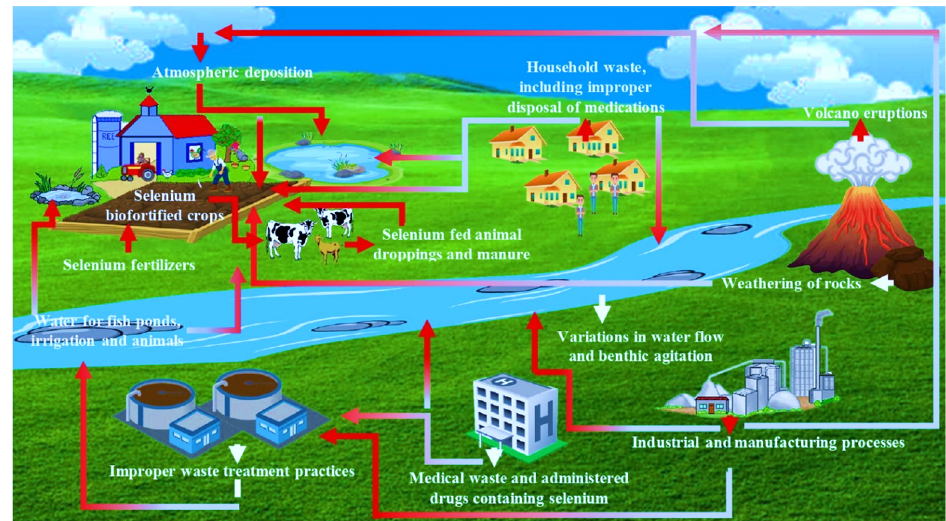
Figure 1. Sources and pathways of selenium in the agro-environment.